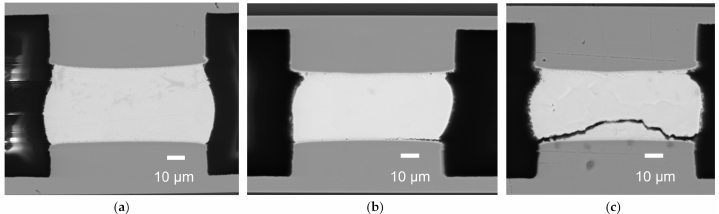
Figure 6. Cross-sectional SEM of the microbumps at different stages of drop impact. ( a ) Cross- sectional SEM of the sample without drop test; ( b ) after 50 drops; ( c ) after the circuit is completely